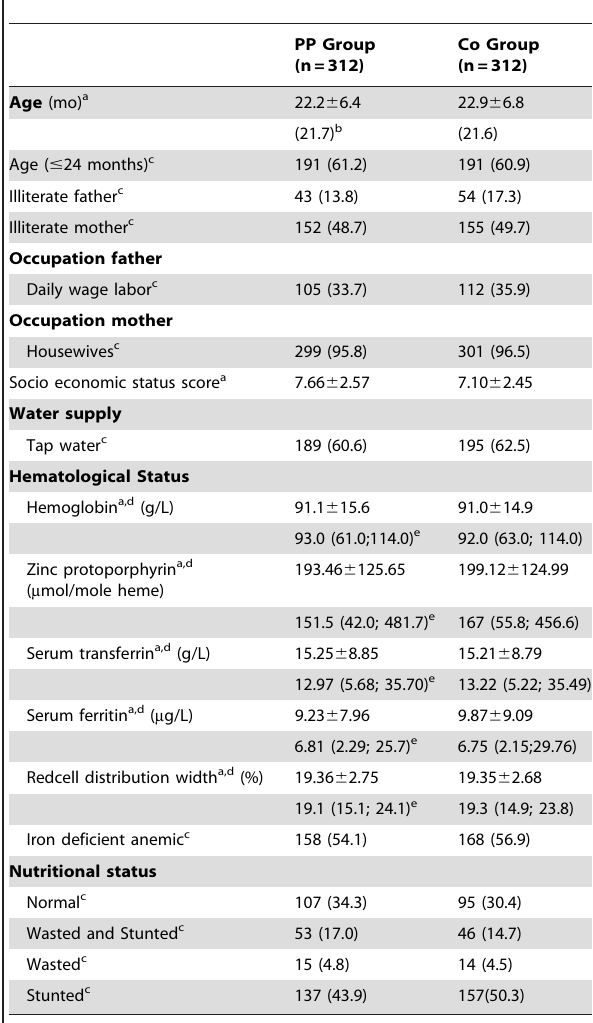
Table 2. Baseline characteristics of prebiotic and probiotic fortified and control milk